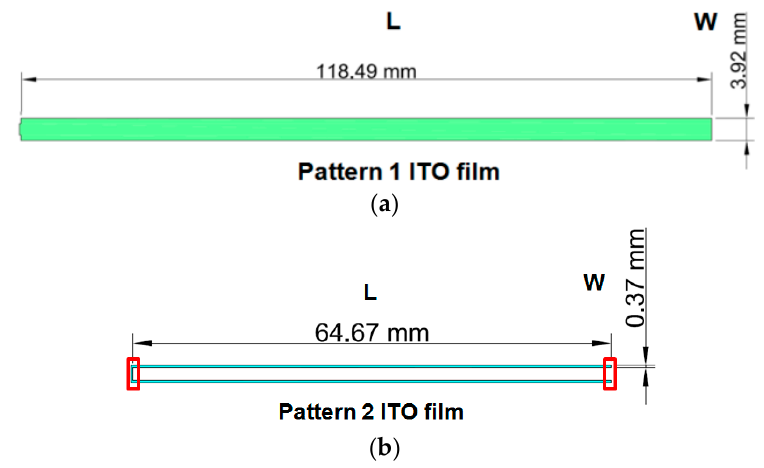
Figure 5. Testing sample of patterned ITO/PET film: ( a ) pattern 1 ITO film (ITO width = 3.92 mm); ( b ) pattern 2 ITO film (ITO width = 0.37 mm).